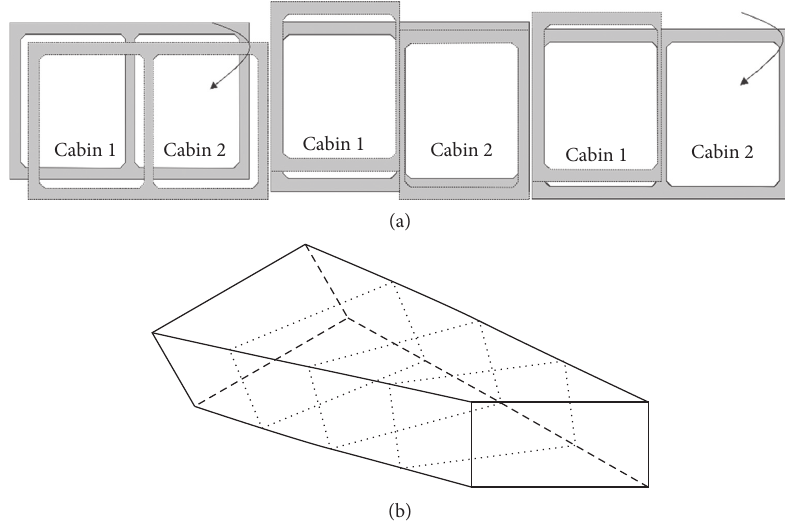
Figure 24: Section torsion diagram.